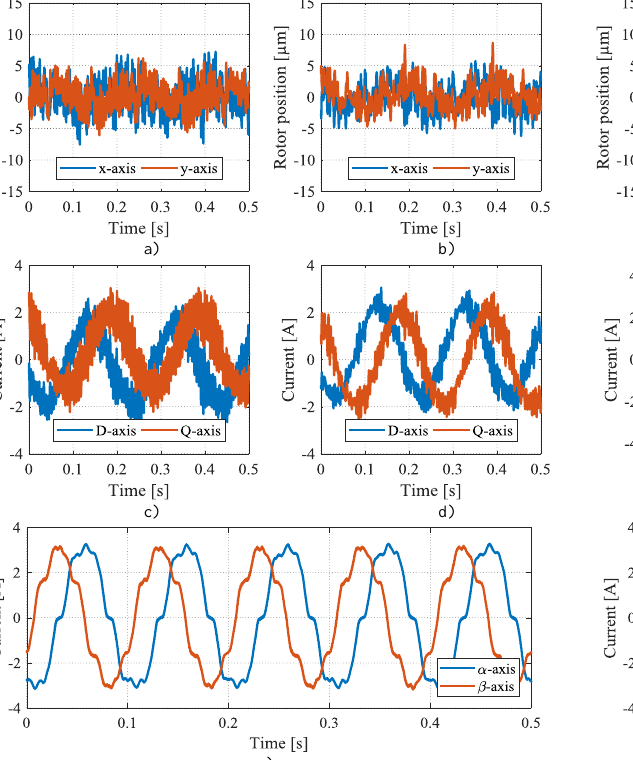
Figure 13: Rotation test with speed of 150 r/min. Mea- sured rotor position is shown for D-end and ND-end in a) and b), respectively. Levita- tion winding current for D-end and ND-end is shown in c) and d). respectively. Torque producing current in the D-end motor wind- ings is shown in e). The motor currents are represented in αβ -armature reference frame.